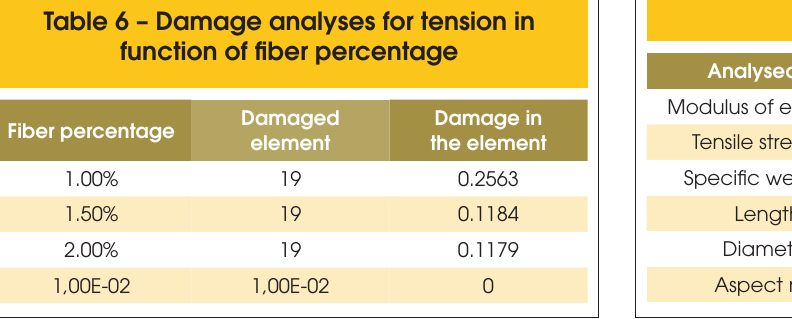
Table 7 – Steel fiber properties used by Lopes